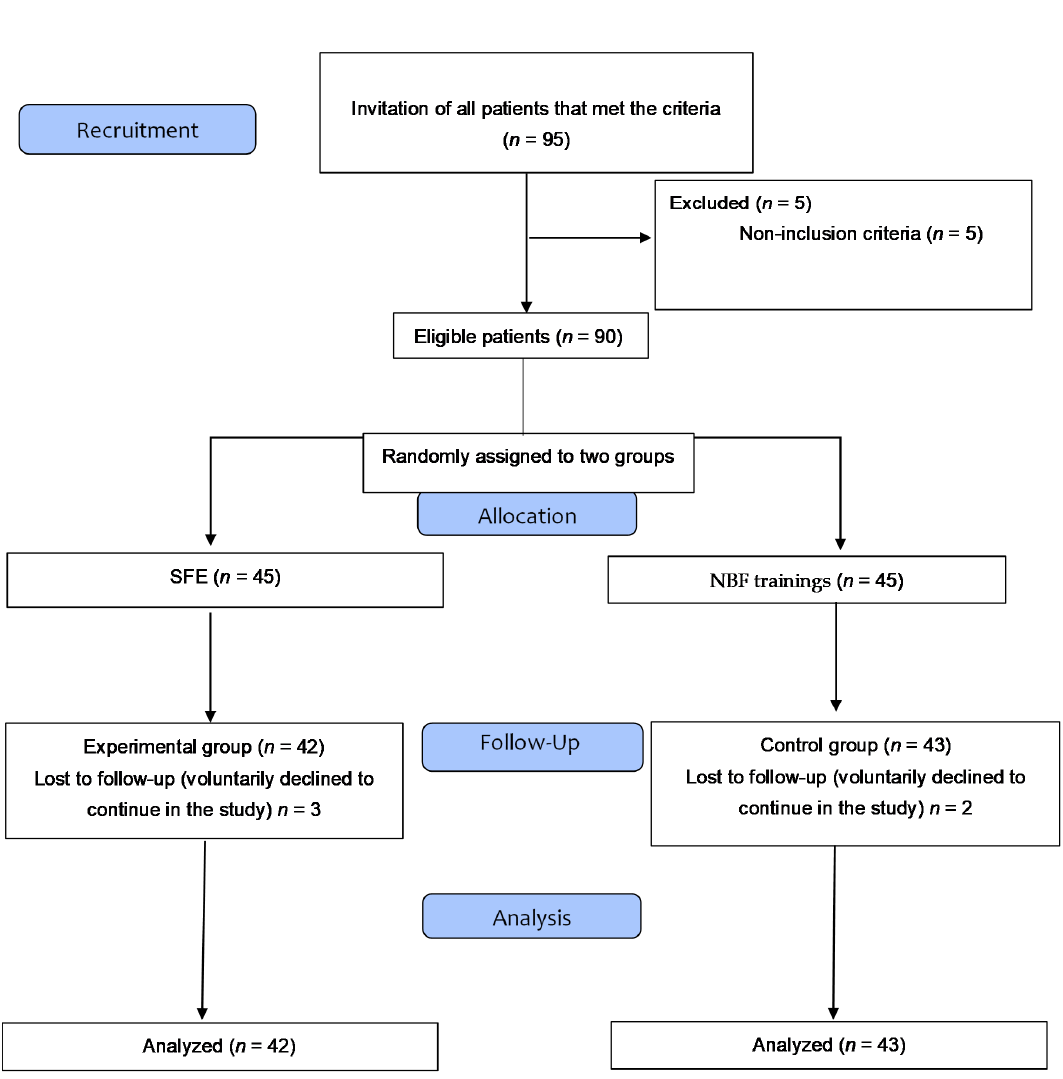
Figure 1. CONSORT flow diagram. SFE; short foot exercise. NBF; non-biomechanical function.